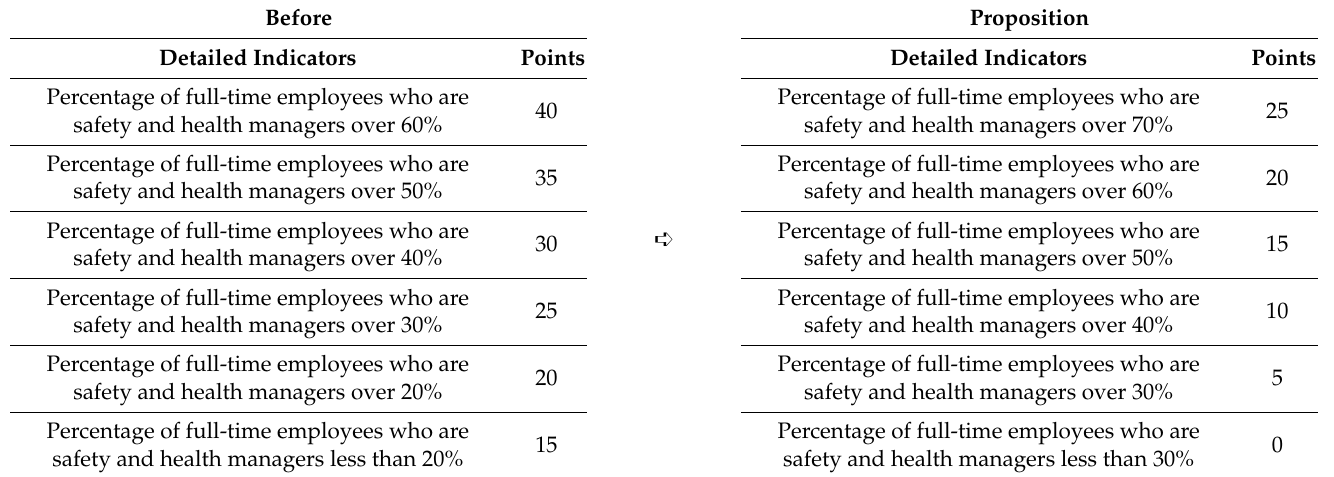
Table 11. Evaluation details for percentage of full-time employees who are safety and health